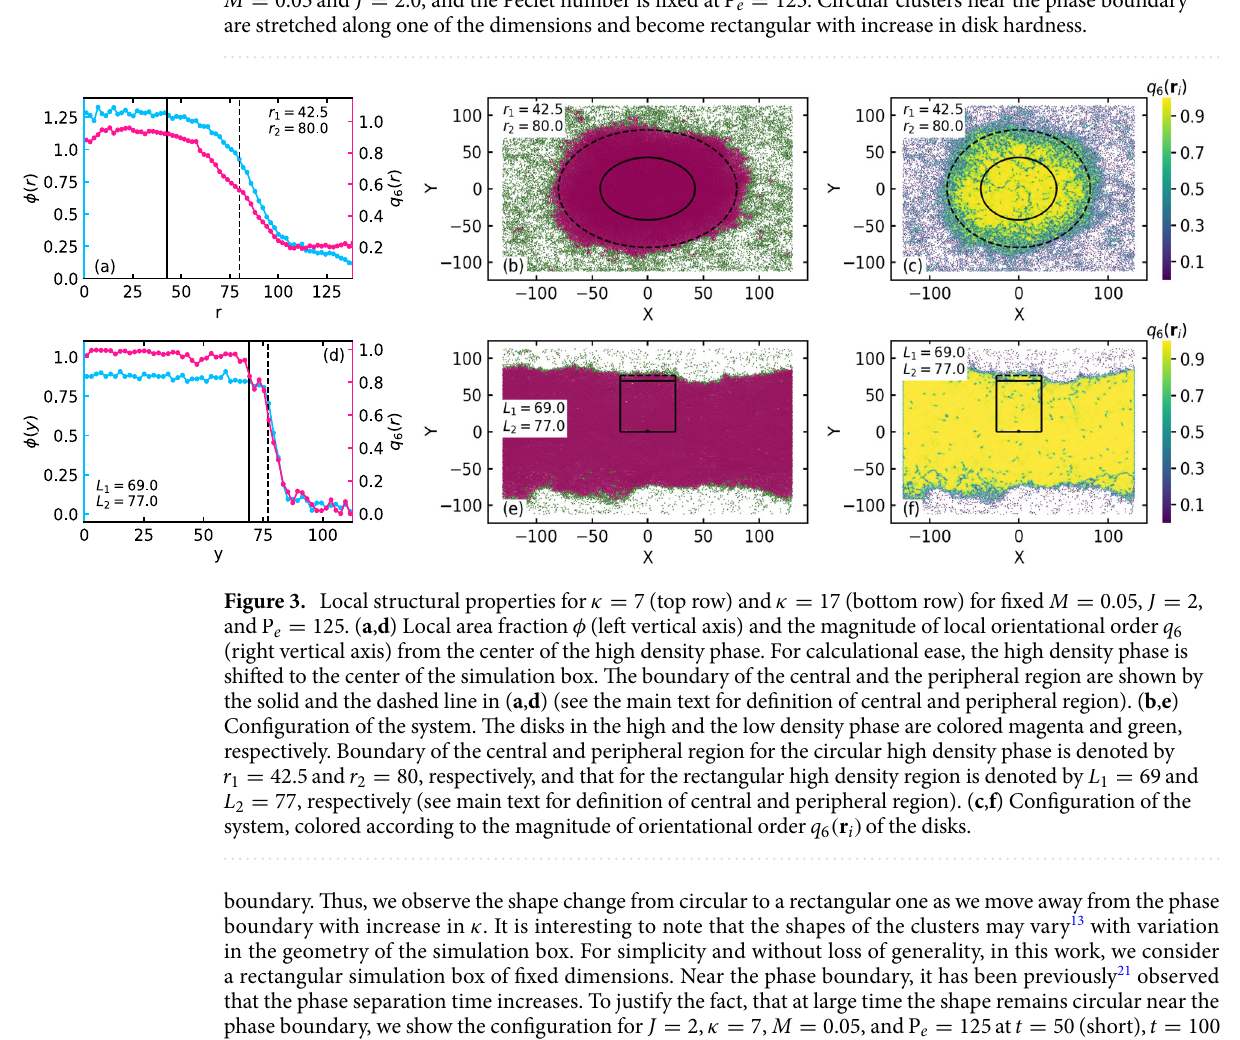
6 , ( b ) κ 8 , ( c ) κ 10 , ( d ) κ 11 , and ( e ) κ 18 . Disks = = = = = = 125 . Circular clusters near the phase boundary e